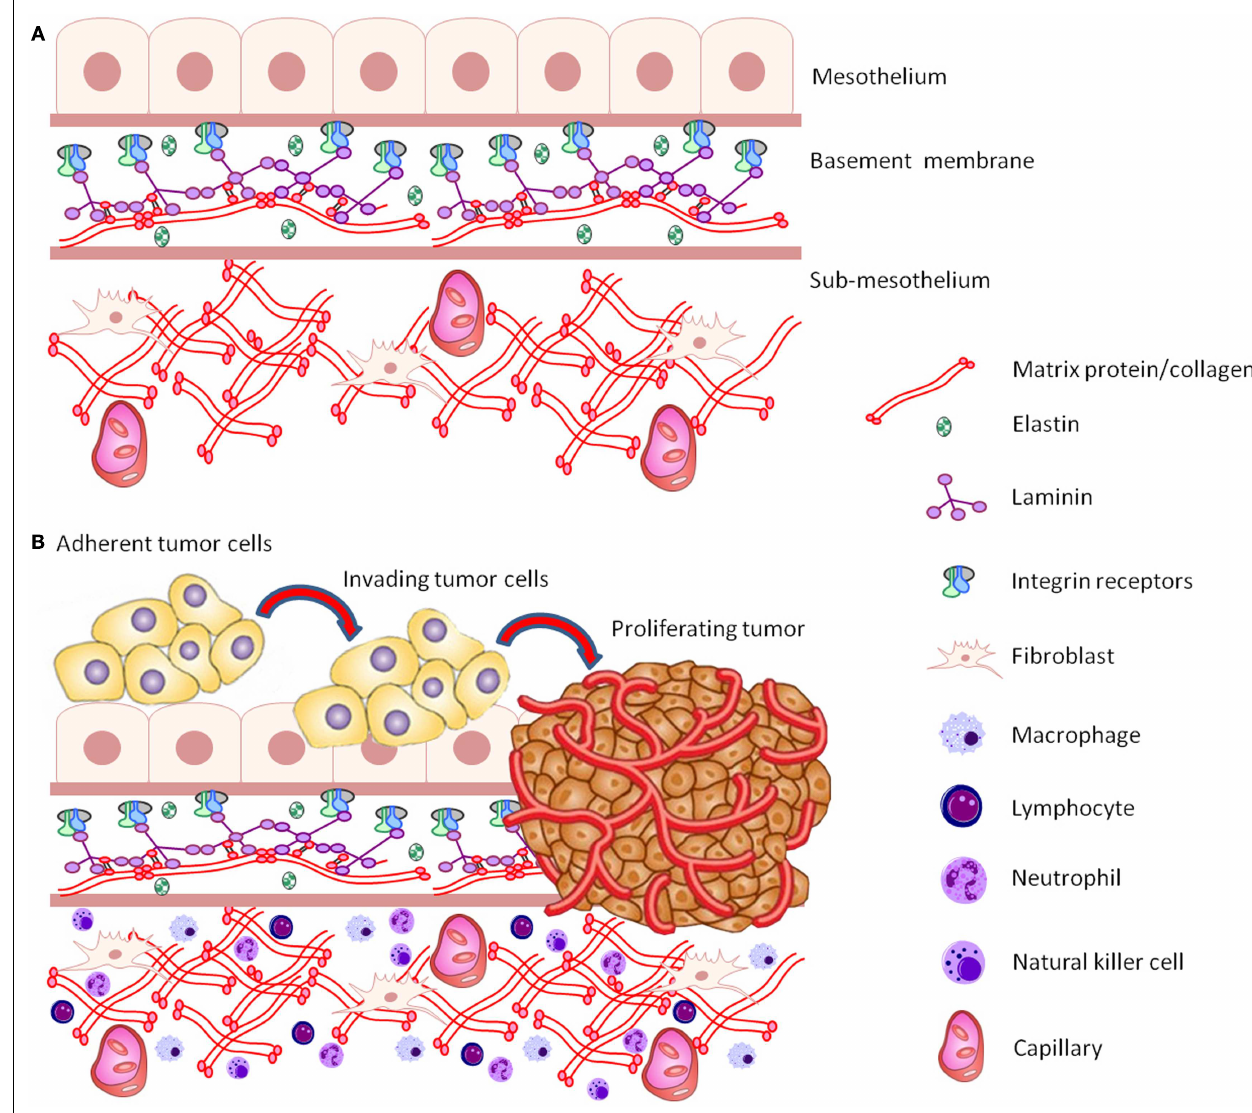
FIGURE 1 | (A) Schematic representation of the structure and components of the common peritoneal site of ovarian cancer metastasis. (B) Schematic representation of a cluster of adherent ovarian cancer cells invading, proliferating, and destroying basement membrane ECM tissue